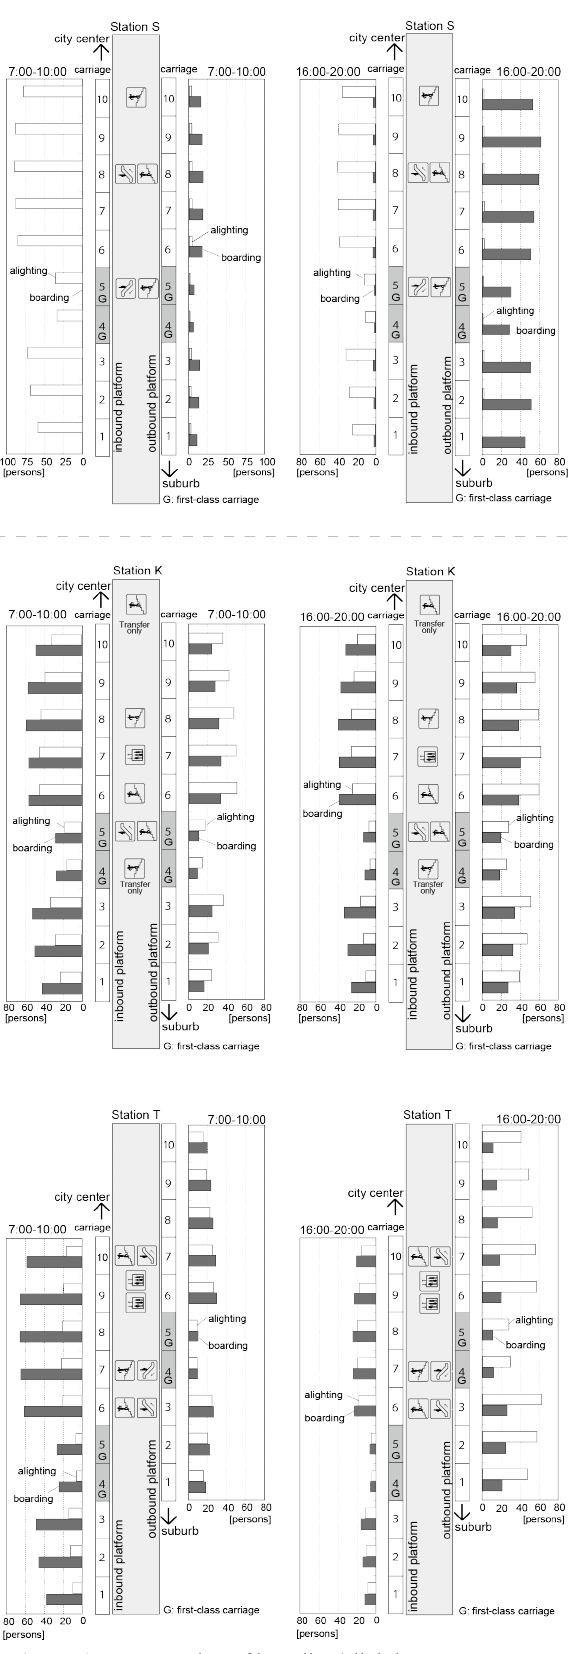
Figure 6 . Mean number of boarding/alighting passengers per carriage per time